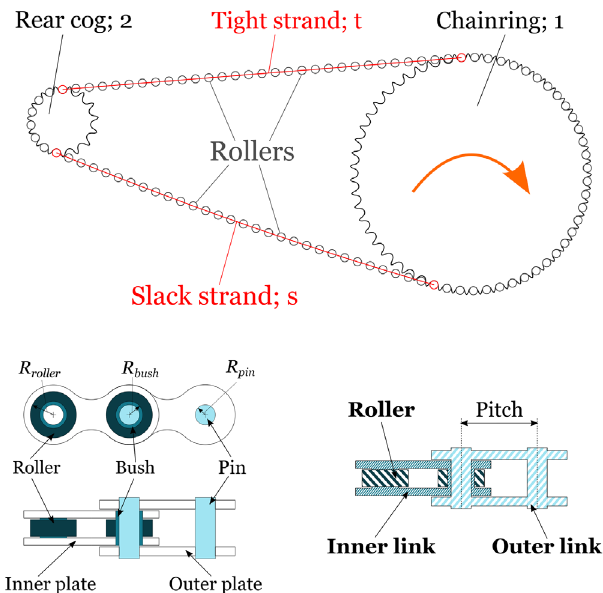
Fig. 2. Vocabulary for cycling chain